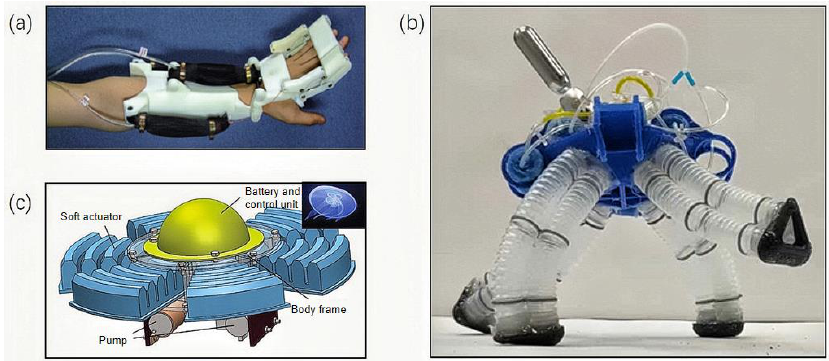
Figure 1. ( a ) DULEX [20]; ( b ) A soft-legged untethered quadruped robot [21]; ( c ) A bionic jellyfish [23].